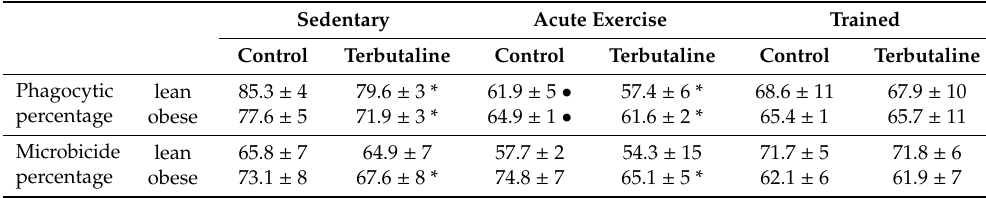
Each value represents the mean ± SEM of independent assays performed in duplicate. * p < 0.05 with respect to the corresponding control value, in the absence of terbutaline; • p < 0.05 with respect to the sedentary control group. Table 4. Influence of exercise on the relative effect of the β 2-adrenergic agonist terbutaline on the phagocytic and microbicide percentages of peritoneal macrophages from lean and obese mice (sedentary, acute exercise, and trained mice) (giving 100 to control values in the absence of terbutaline). With Terbutaline Without Terbutaline Sedentary Acute Exercise Trained Phagocytic percentage